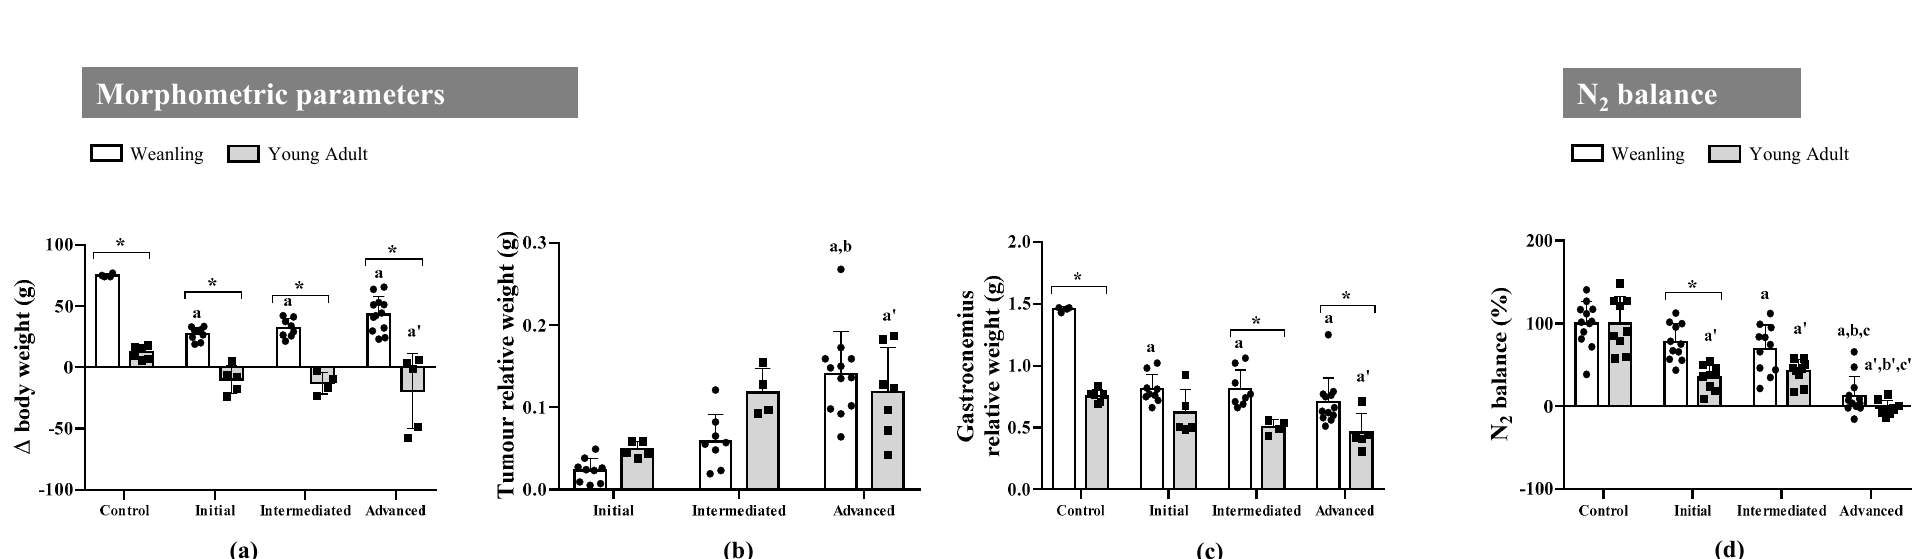
Figure 1. Morphometric parameters and N 2 balance identified in weanling and young adult female Walker-256 tumour-bearing rats. ( a ) ∆ body weight, ( b ) relative tumour weight, ( c ) relative gastrocnemius weight, and ( d ) N 2 balance, distributed into control (WC and AC) and initial (WWi and AWi), intermediate (WWm and AWm), and advanced (WWa and AWa) Walker tumour-bearing animals. Legend: ∆ body weight was calculated as [final body weight − initial body weight] for non-tumour-bearing groups and as [(final body weight − tumour weight) − initial body weight] for tumour-bearing groups. The relative values were calculated by dividing the tumour and gastrocnemius muscle weights by each animal’s respective initial body weight. N 2 balance was calculated as [food intake N 2 − (urinary N 2 + faecal N 2 )]. Data were expressed as means ± standard deviation and analysed by two-way ANOVA, followed by post-hoc Tukey’s honestly significant difference. p -value < 0.05 in comparison with the (a) WC, (b) WWi, and (c) WWm groups; with the (a’) AC, (b’) AWi, and (c’) AWm groups; and with the young adult (*) group.